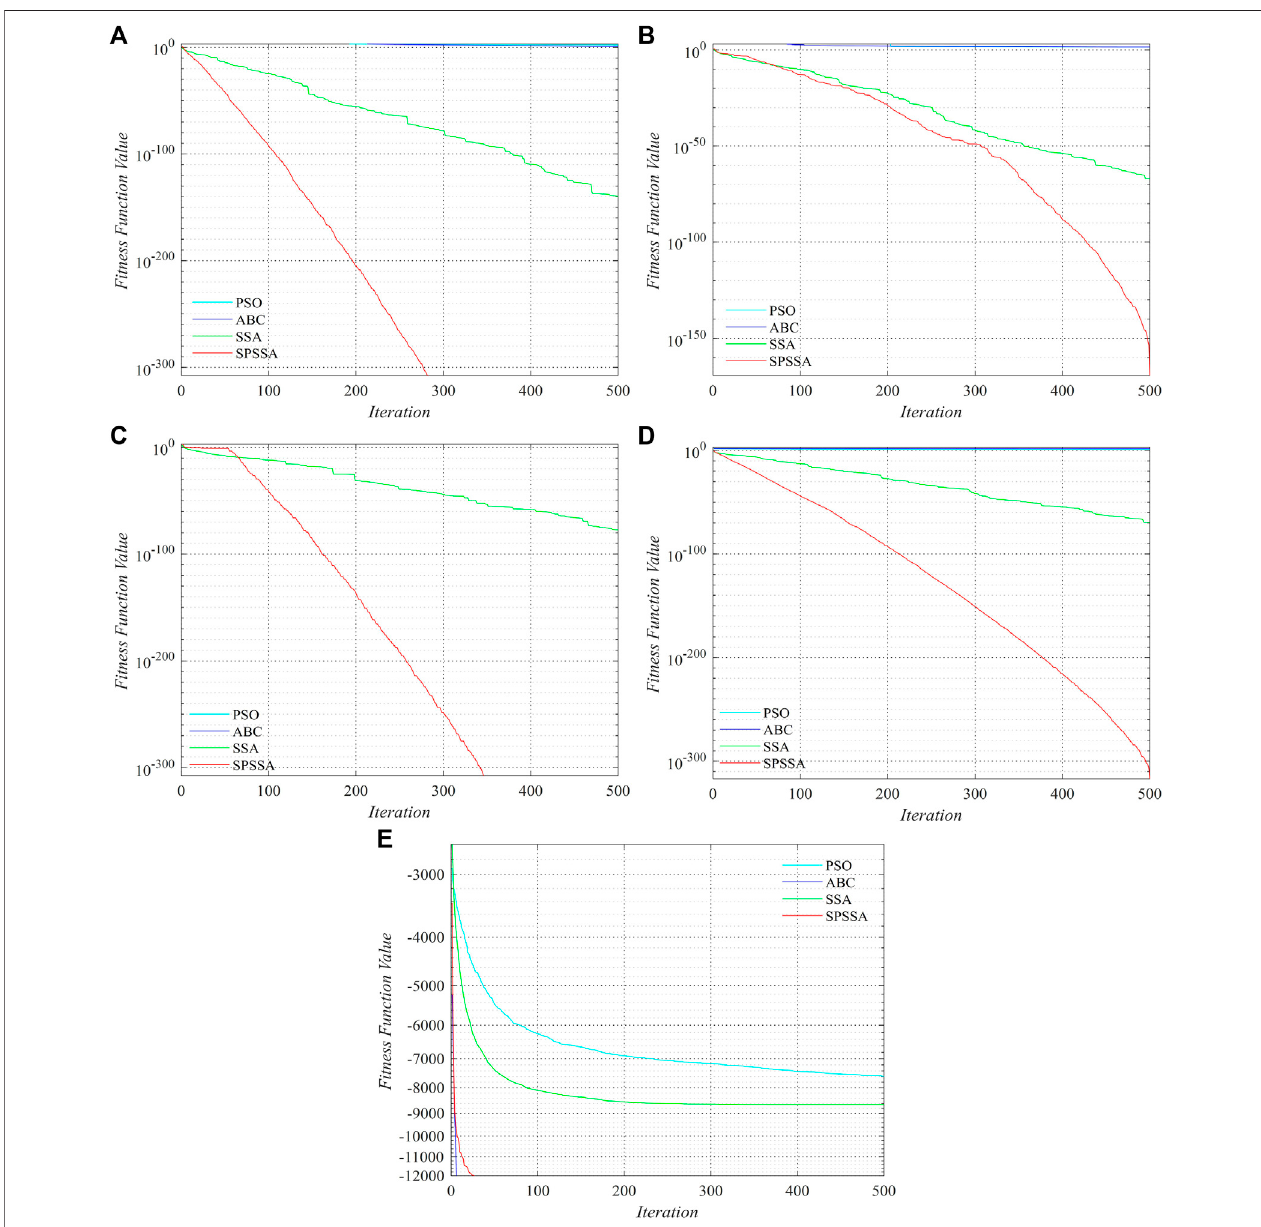
FIGURE 2 | Four algorithms ’ convergence curves on fi ve benchmark functions. (A) F1; (B) F2; (C) F3; (D) F4; (E) F5.